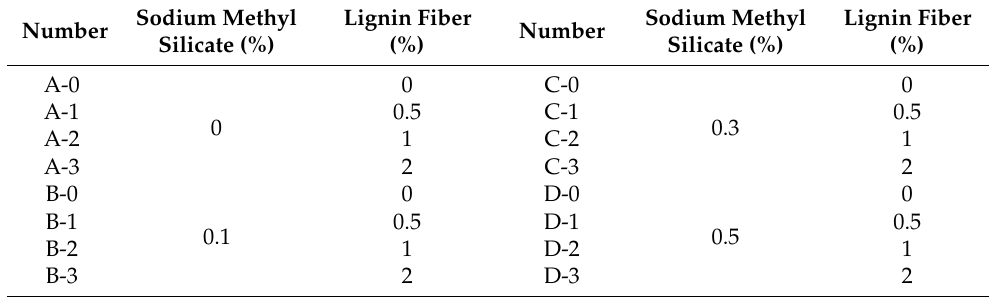
Table 3. Material mix proportion design.